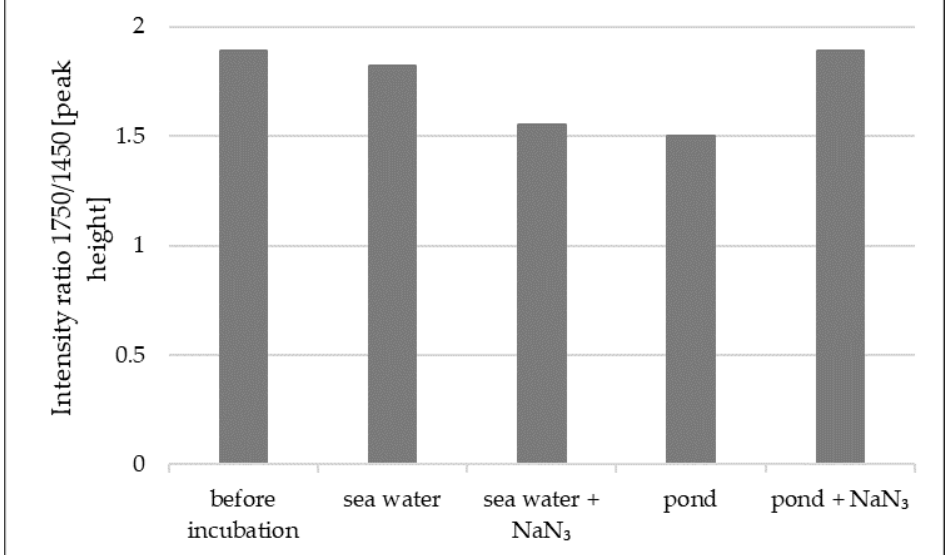
Figure 5. The intensity ratio of the band at about 1750 cm − 1 to band approximately 1450 cm − 1 for PLA before and after 12 months of incubation in aqueous environments. Source: Own research.